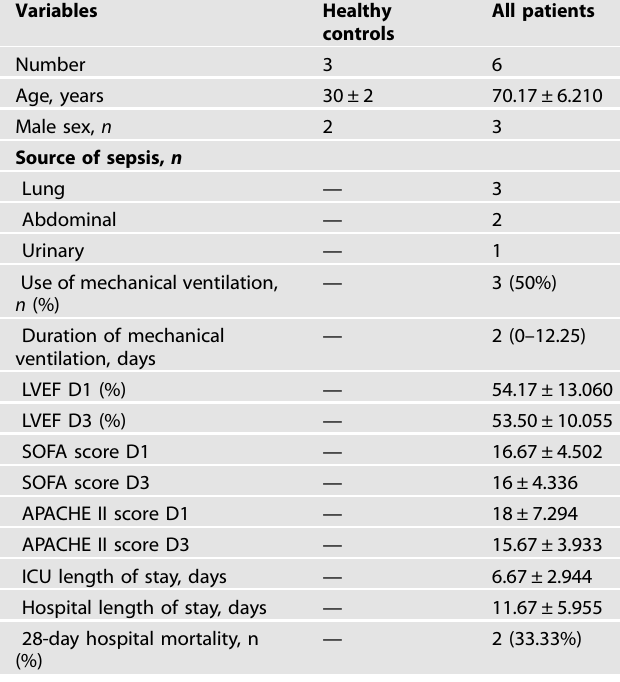
Table 1. Clinical characteristics of healthy controls and patients with sepsis used for small RNA-sequence analysis of neutrophil-derived EVs.